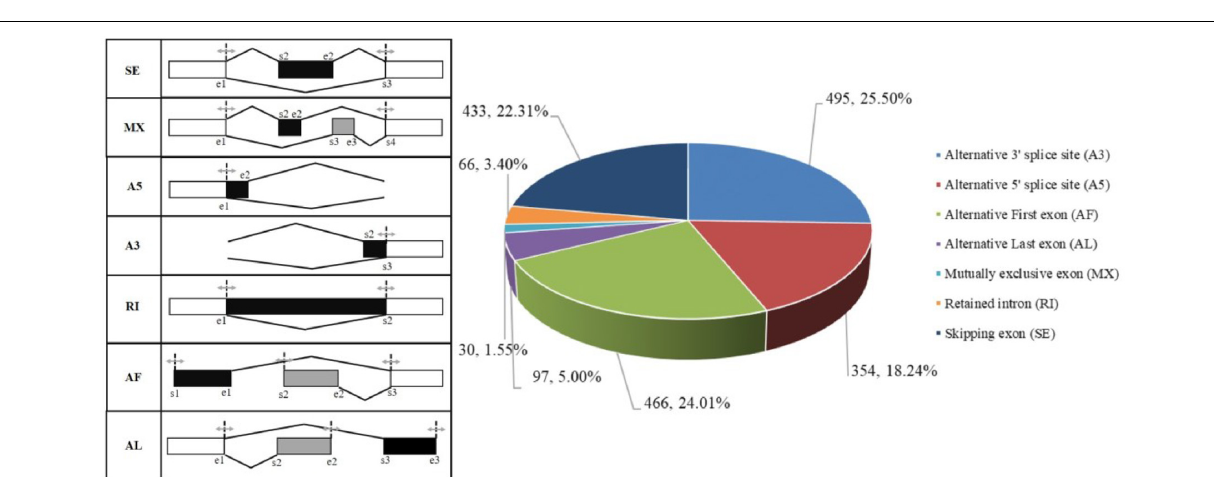
FIGURE 5 | The types and number of AS events in the R. typus FL